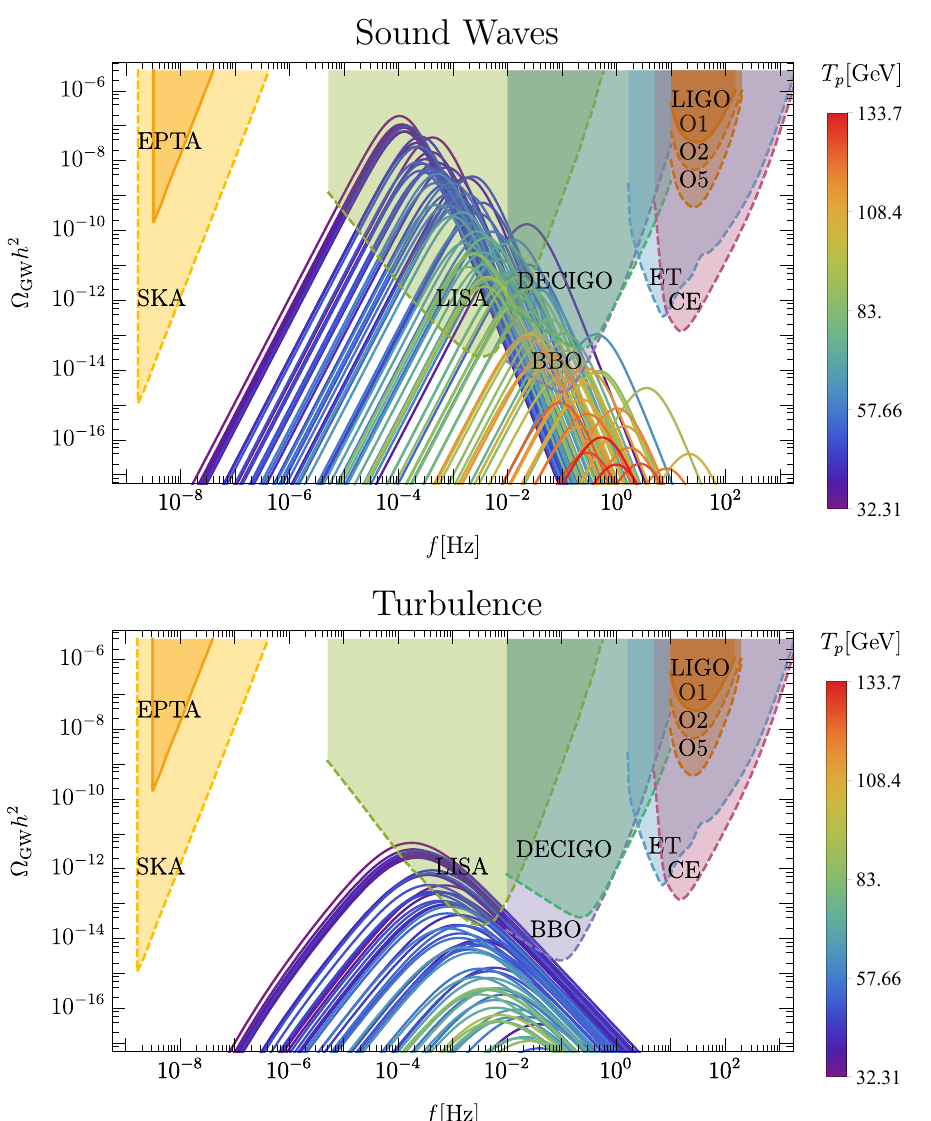
Figure 10 . Gravitational wave (GW) spectra of viable points as sourced by sound waves (top panel) and turbulence (bottom panel) along with their dependence on the percolation temperature T p . Current sensitivity bands of LIGO and EPTA, as well as detection prospects of LISA, DECIGO, BBO and SKA are also shown for comparison (see text for more